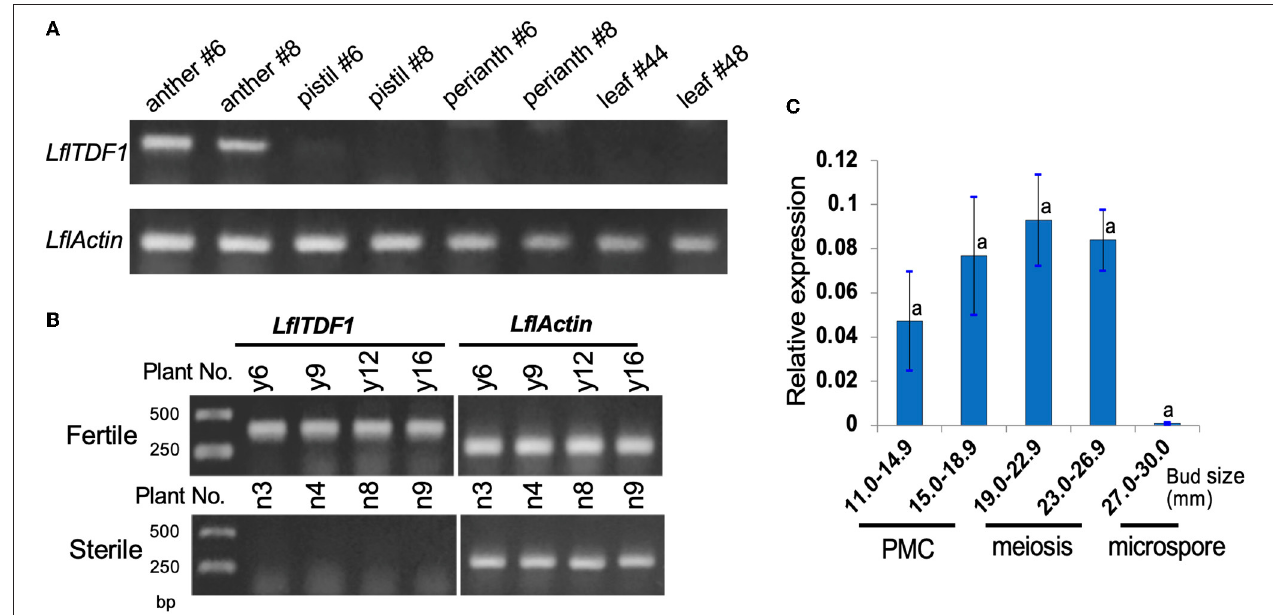
FIGURE 3 | Expression analysis of LflTDF1 gene by RT-PCR and qRT-PCR. The samples were collected from the population derived from the cross of pollen-sterile and pollen-fertile segregants. Actin gene of L . × formolongi was used as the internal control. (A) Tissue-specific expression of LflTDF1 in the pollen-fertile segregants. The samples were collected from the two different plants indicated by #. (B) The expression of LflTDF1 in the anthers (collected from the bud size 14–26mm) of the pollen-fertile and sterile segregants. Four different samples of the pollen-sterile and pollen-fertile segregants were shown. (C) qRT-PCR detected the expression of LflTDF1 in the anthers collected from the buds of pollen-fertile segregants having different sizes. The pollen developmental stages are referred in Figure 2 . Error bar represents standard deviation, and means were tested by Tukey’s test at P =